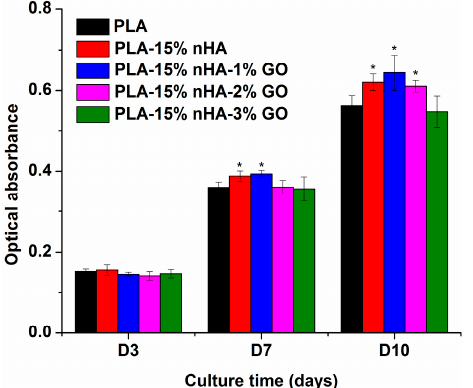
Figure 12. The MTT assay results of Saos-2 cells cultured on neat PLA and its composite fibrous mats for 3, 7 and 10 days. * p < 0.05.